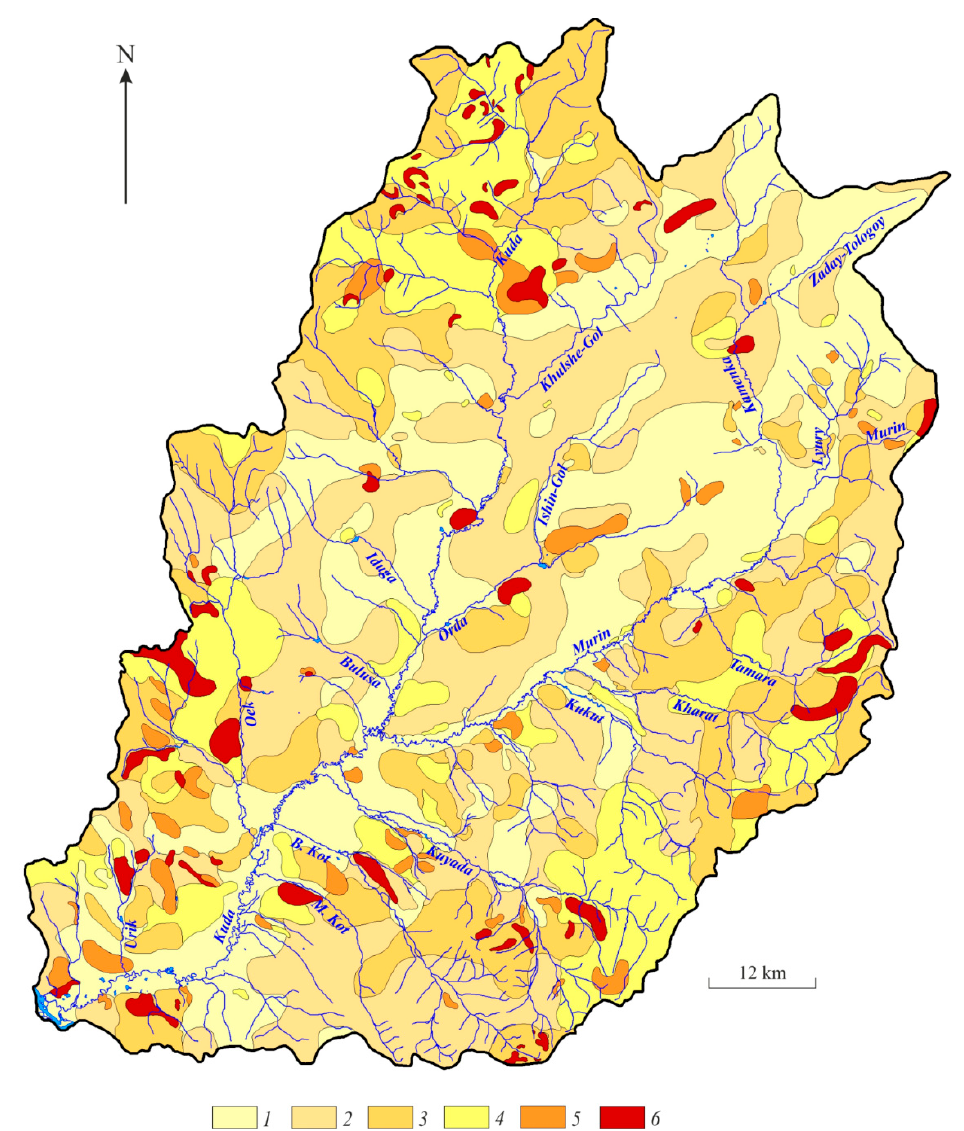
Figure 3. Erosion zoning of the Kuda basin. Zones: 1. no erosion hazard (loss less than 1 tha per year); 2. Weak erosion hazard (loss 1–2.5 tha); 3. Moderate erosion hazard (2.5–5 tha); 4. Medium erosion hazard (loss 5–10 tha); 5. Strong erosion hazard (10–20 tha); 6. Extreme erosion hazard (loss more than 20 tha per year).